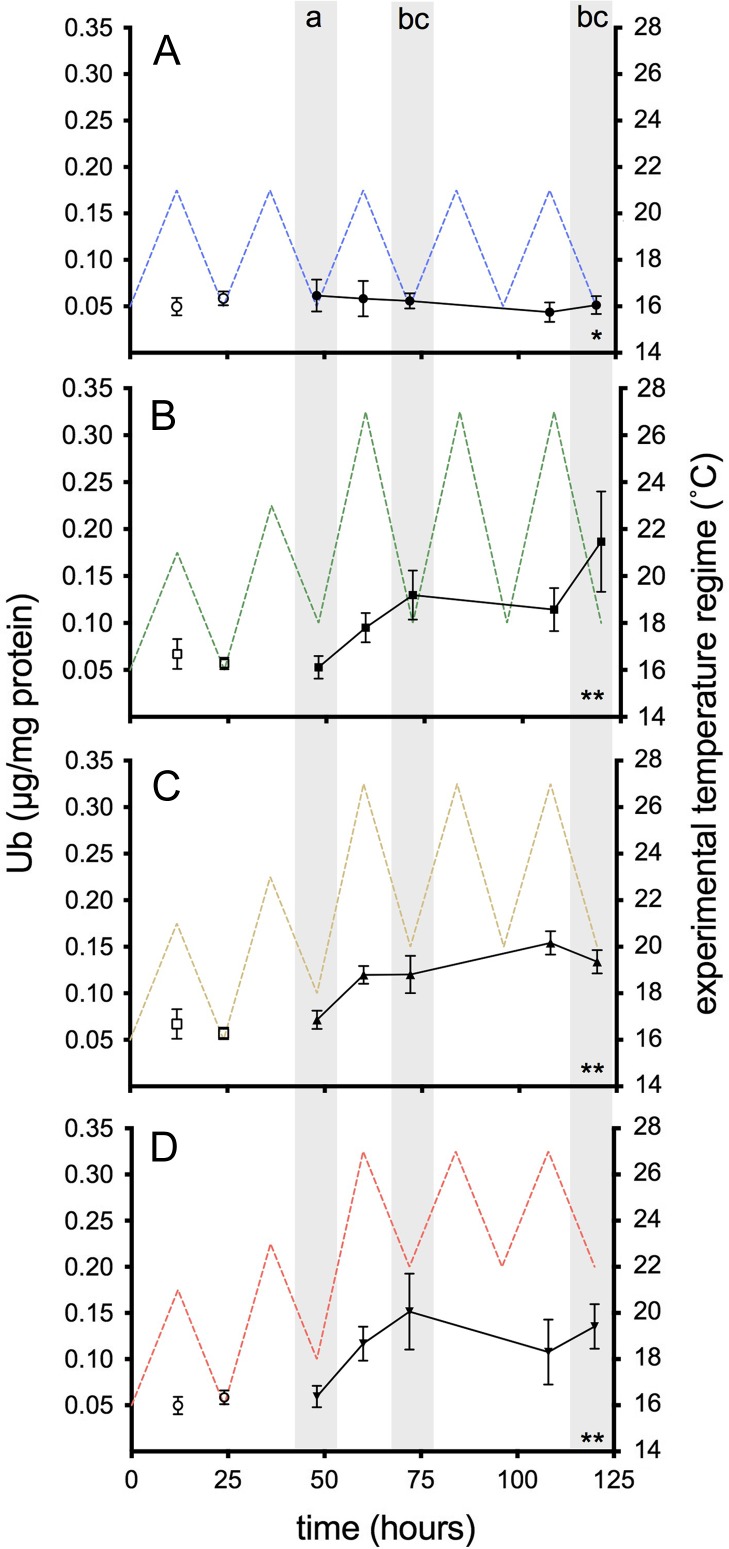
RBC Ub in juvenile salmon exposed to the following diel cycles: (A) 16–21°C only; or multi-day thermal stress (closed symbols; 60–120 h) of (B) 18–27°C; (C) 20–27°C; (D) 22–27°C. Points represent mean ± SEM (n = 4–9). Pre-thermal stress sampling (open symbols; t = 12 and 24 h) assessed the effect of ‘trial’ and was not included in the analysis. Asterisks indicate significant differences between treatments. Lettered shaded bars indicate significant differences between time points (P < 0.05).